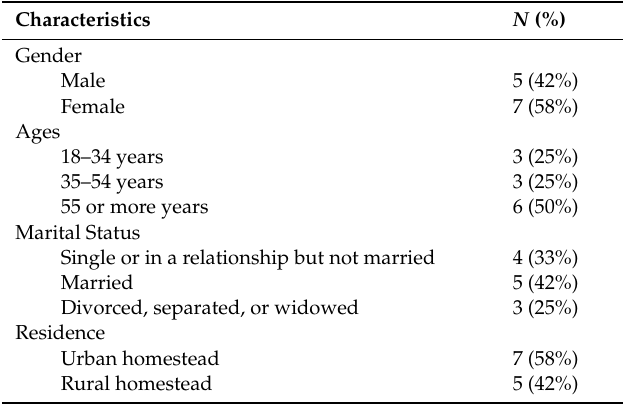
Table 1. Characteristics of